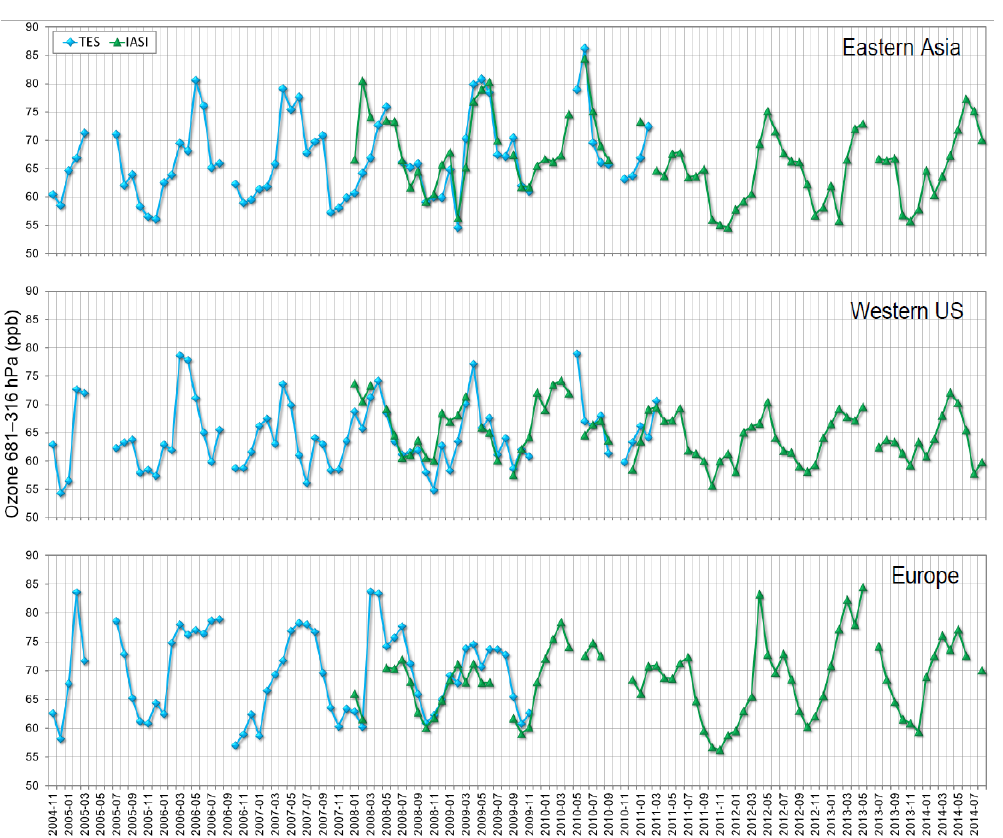
Figure 7. Time series of partial column-averaged ozone for the three ROIs. IASI-TOE monthly means have been adjusted by a constant value of +